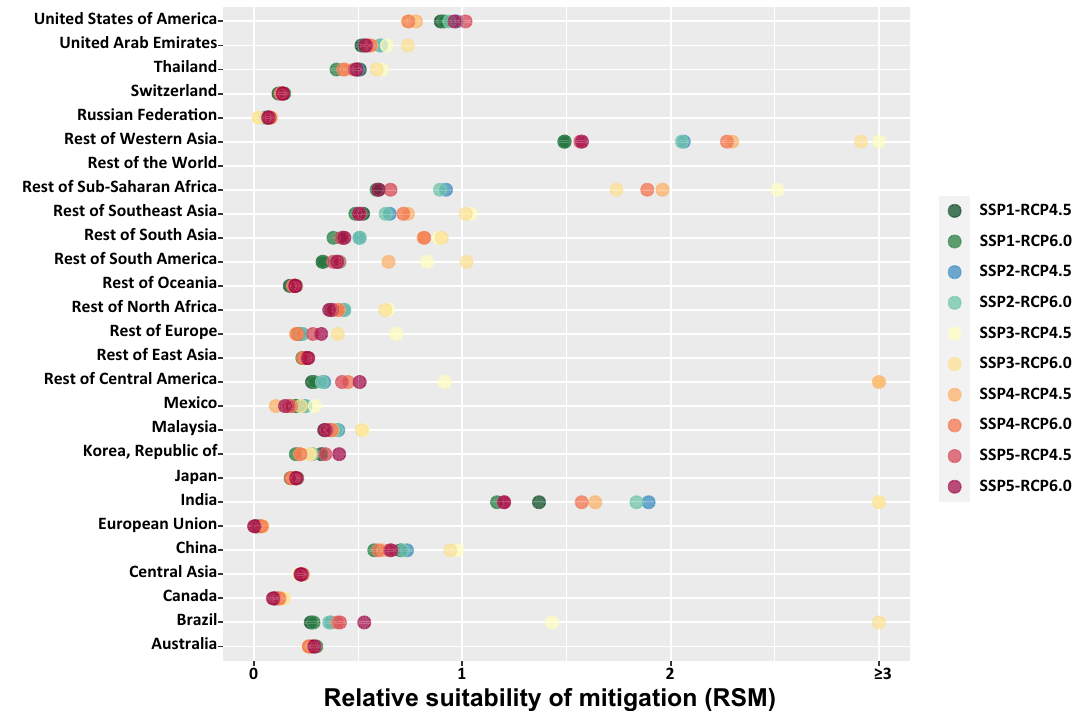
Fig. 4 Substantial cross-regional disparity in suitability of carbon mitigation. RSM (relative suitability of mitigation) for each region under each scenario. RSM is de fi ned as the ratio of normalized SCC (the social cost of carbon) to normalized RCC (the average reduction cost of carbon). Detailed values of RSM for each emitter under each scenario can be found in Supplementary Data Supplementary Fig. 7. Although the accuracy of each model is subject to errors in model parameters and assumptions 6 , the multi- model averaging reduces the in fl uence of errors in individual models. We also provided the comparison of SCC and RCC based on each IAM model in Supplementary Fig. 3b – f.